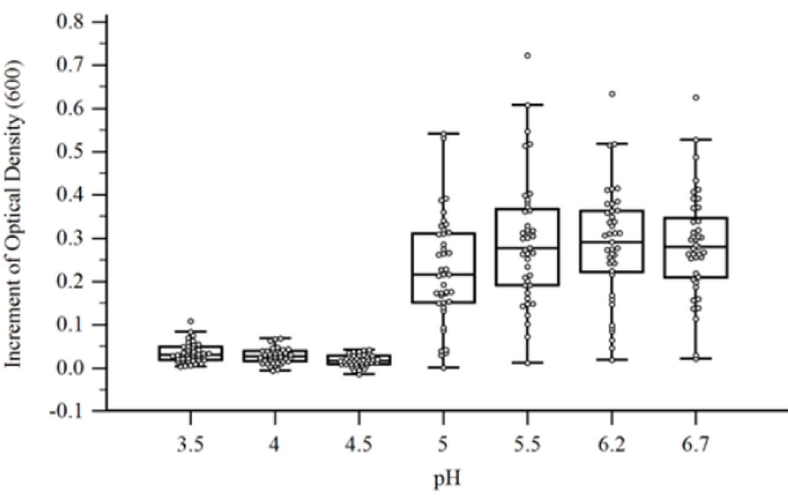
Fig. 5. Effect of pH on bacterial growth. The increment of optical density after 48 h of incubation for each isolate in media containing different pH. Each box-and-whisker plot constitutes one pH value. The extent of the box encompasses the interquartile range of the optical density increment, whiskers extend to maximum and minimum values, and the line within each box represents the median. Outliers are represented as open black circles.